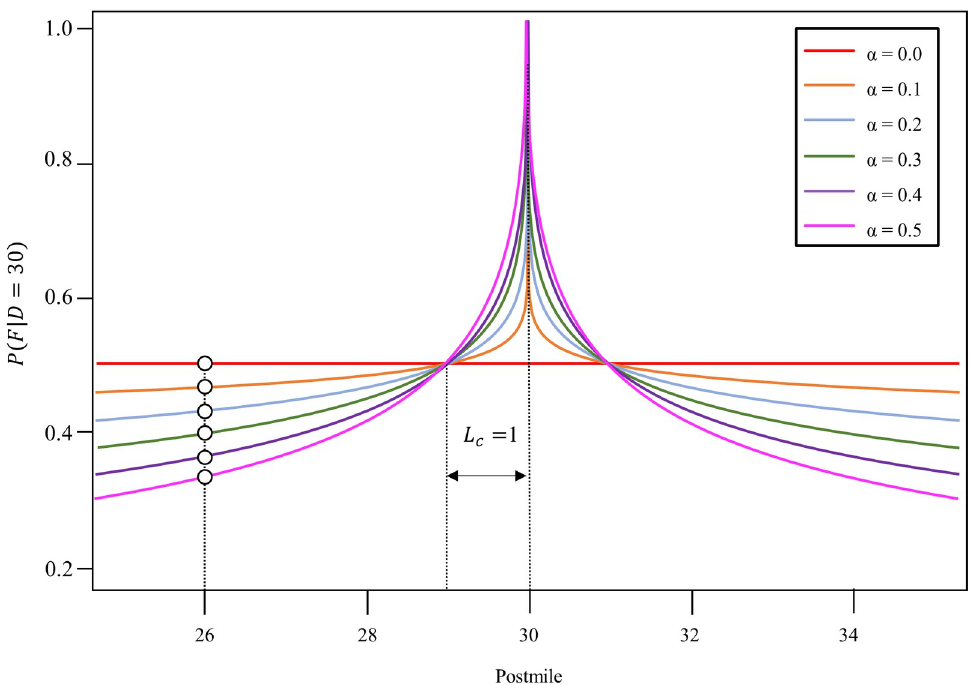
Fig 4. Individual likelihoods of a fatal collision according to α when the R location is D =